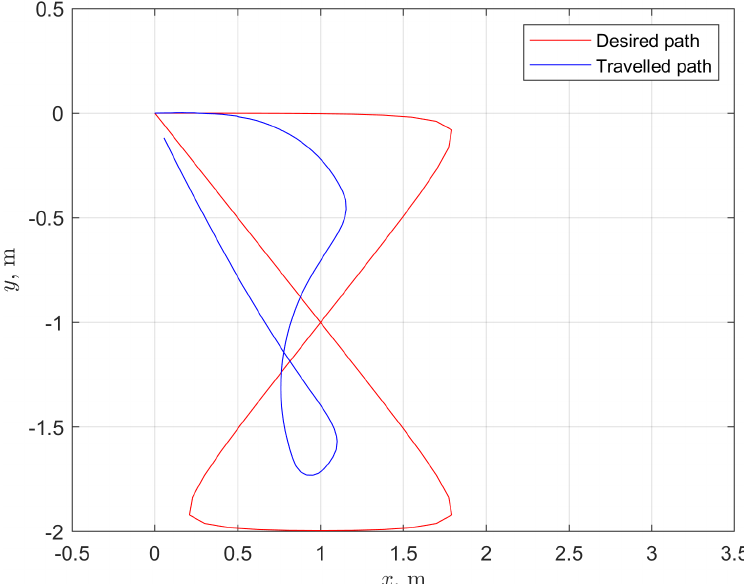
Figure 29. Desired path vs. actually traveled path for the mid value of the cost function equal to 1.0858—track